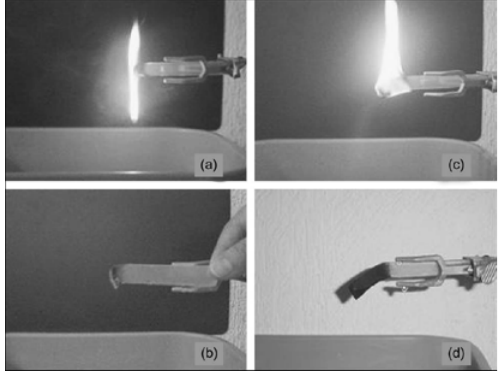
Figure 8. Flammability tests of: (a) EVA and (c) EVA/C20A (after 1 min of burning); (b) EVA and (d) EVA/C20A (after flame extinction). The hybrid contains 6 wt % organoclay (adapted from Ref.